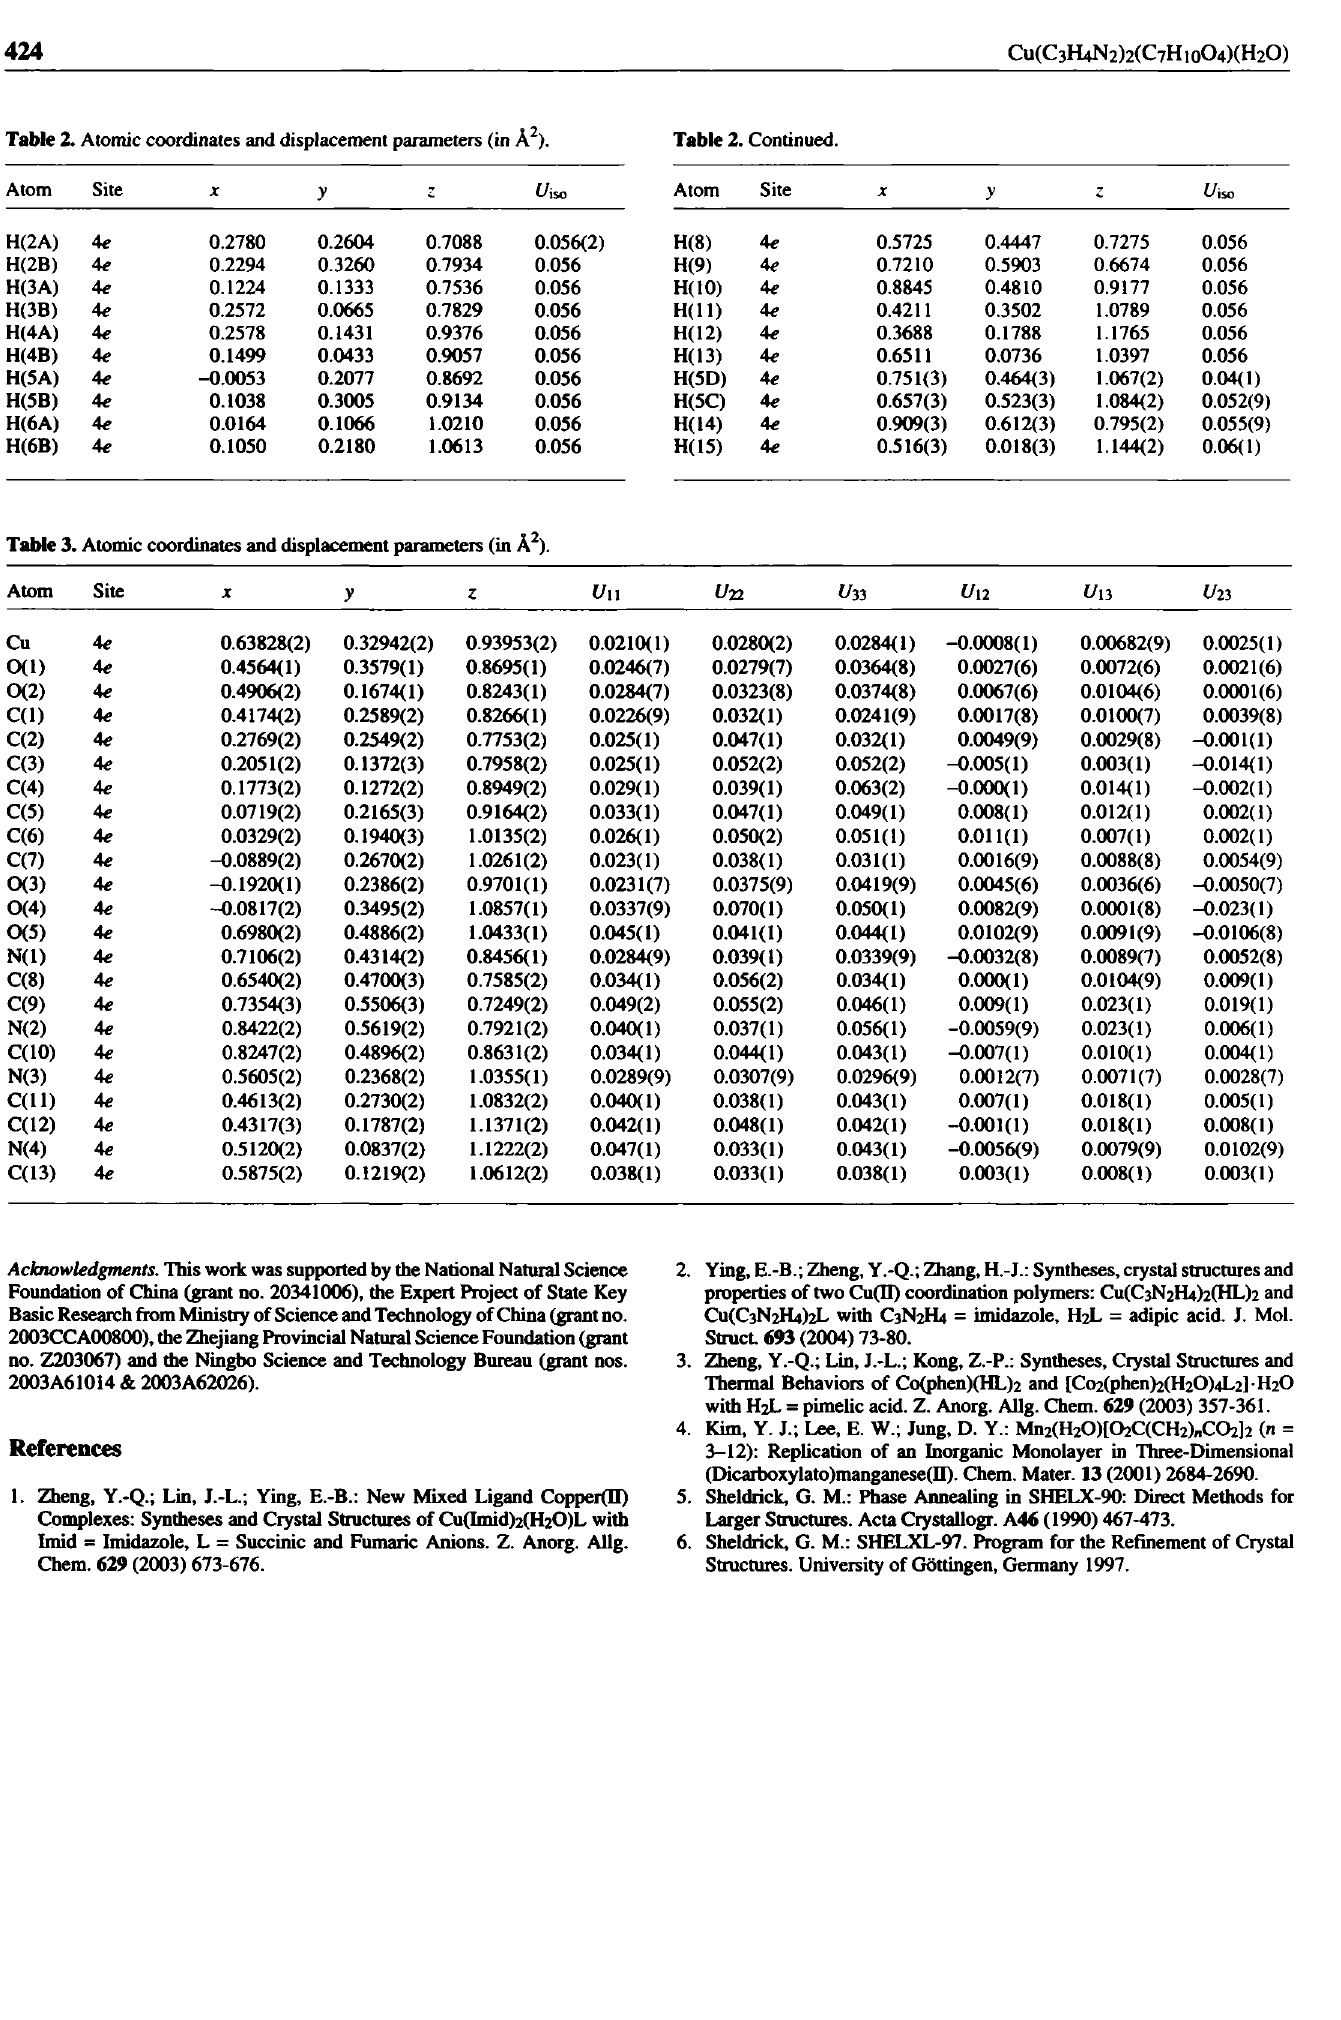
Table 2. Atomic coordinates and displacement parameters (in A 2 ).